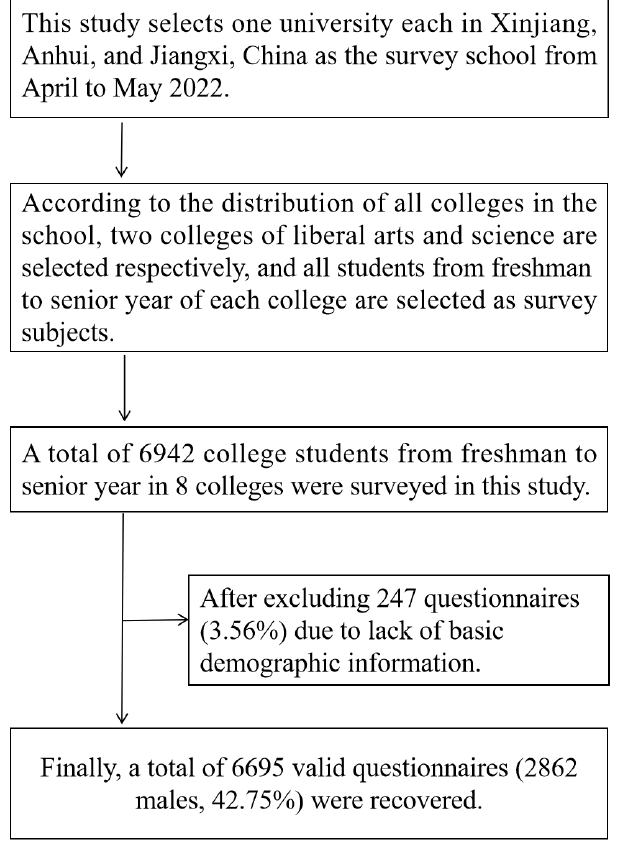
Figure 1. The specific sampling process of participants.